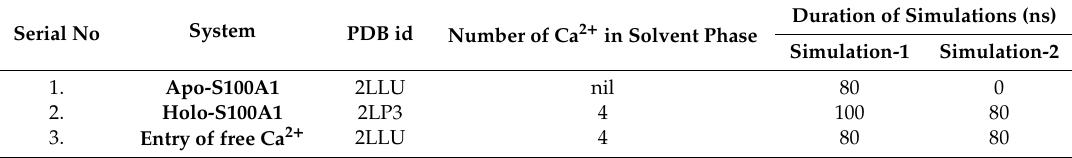
Table 1. Details of the systems and the duration of simulations and